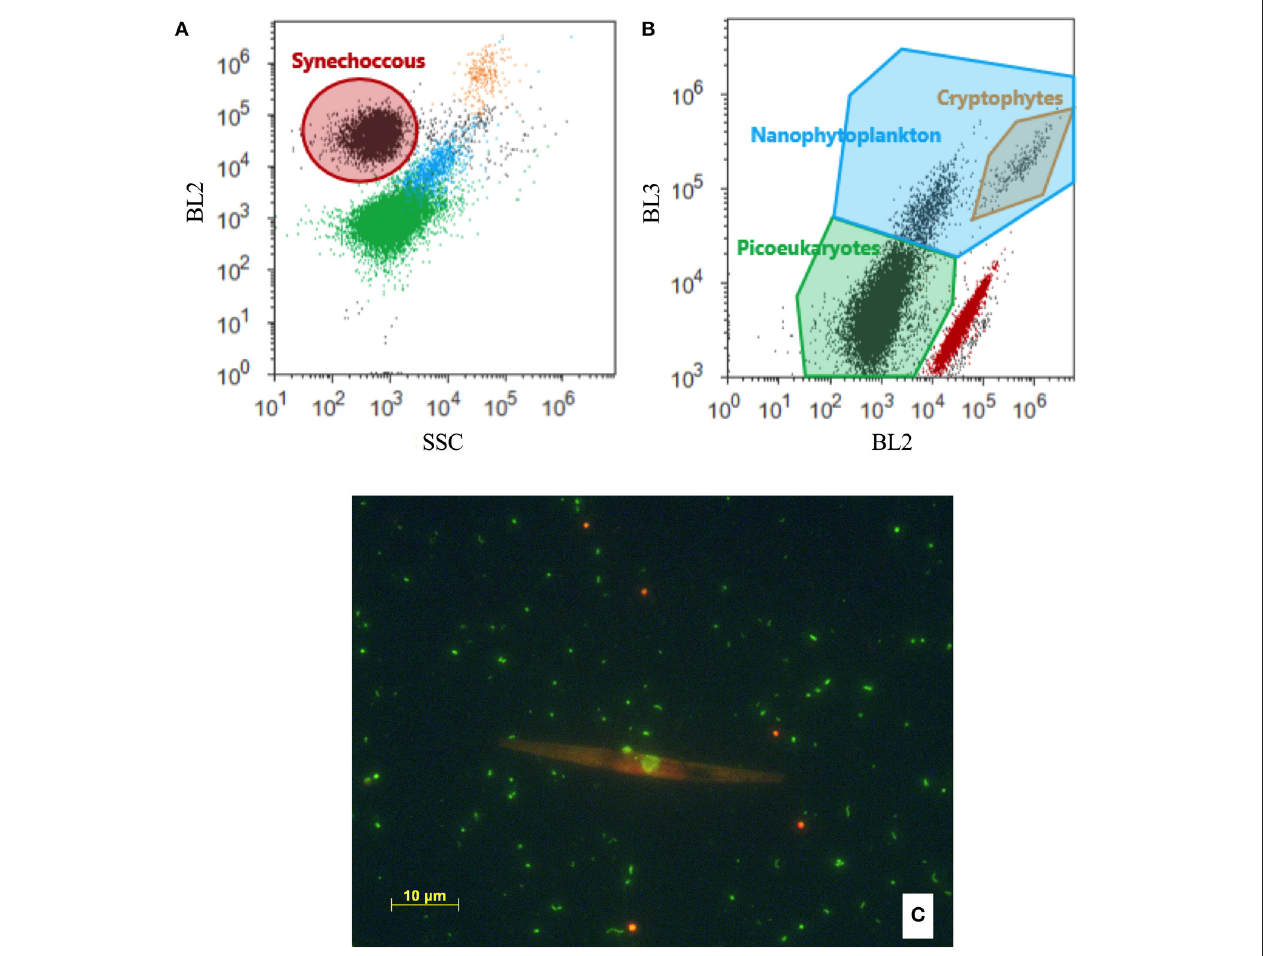
FIGURE 2 | (A,B) Biparametric flow cytometry plots with the applied grouping of the different phytoplankton groups indicated by the solid line. Groups are colored according to their grouping in order to appear on both (A) BL2 (orange fluorescence) vs. SSC (side scatter) and (B) BL3 (red fluorescence) vs. BL2. (C) Microscope image showing the difference in the autofluorescence spectrum of Synechococcus (appear orange) and picoeukaryotes (appear green). The long orange cell is a